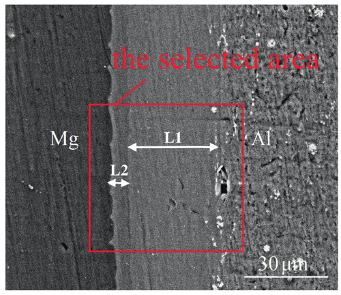
Figure 1: SEM micrographs of the Mg/Al bonded joint.